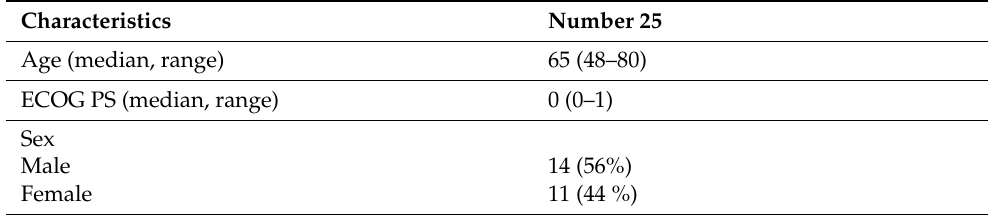
Table 1. Patient’s